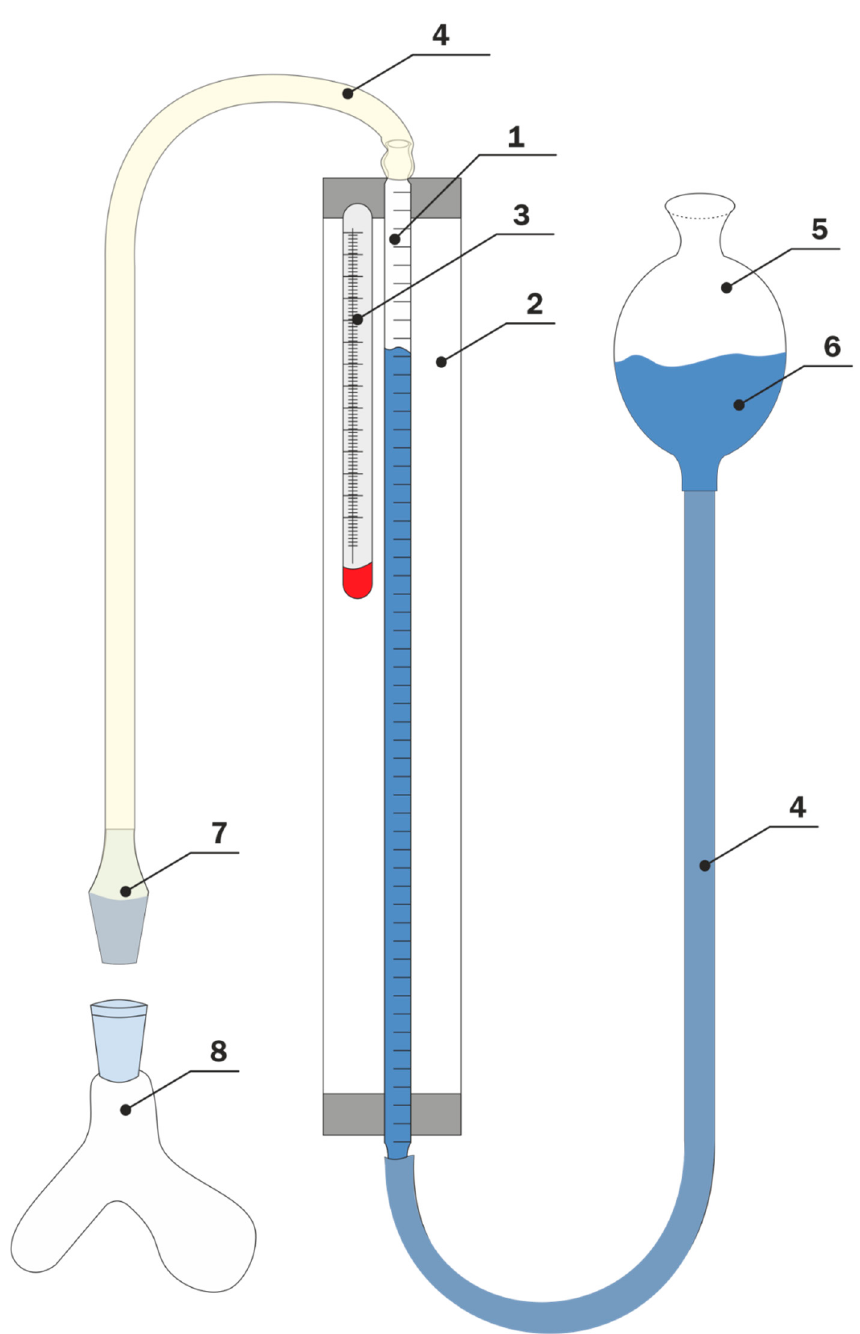
Figure 1. Schematic representation of the laboratory instrument for the determination of Si-OH group content. 1—gas burrete, 2—glass thermostat, 3—thermometer, 4—silicone hosepipe, 5—filler, 6—barrier fluid, 7—adapter, 8—special two-necked fl ask.